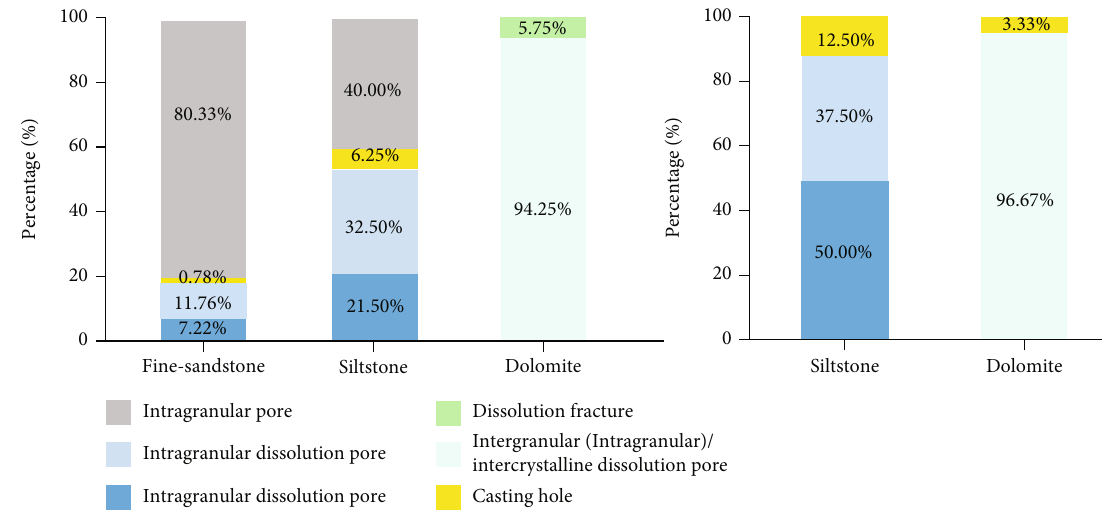
Figure 6: Comparison of di ff erent types of lithologies and storage spaces in the upper and lower sweet spots.